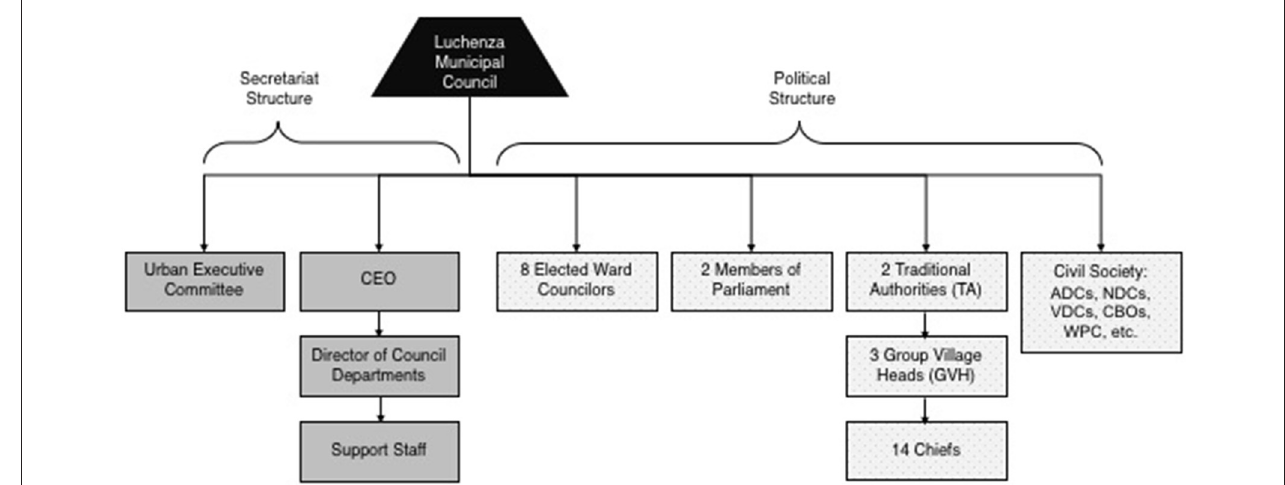
FIGURE 3 | Luchenza Council structure.